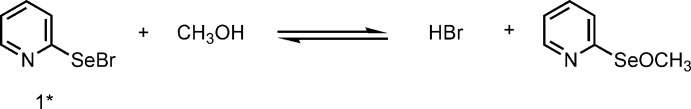
The inter­action of selenenyl bromide 1* with methanol.